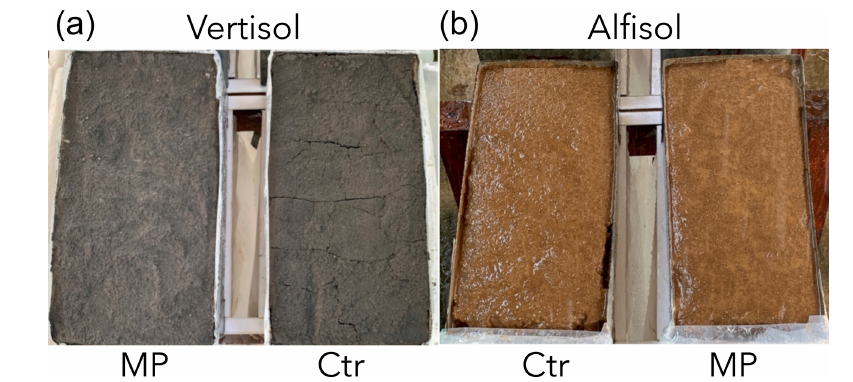
Figure 9. Experimental units of experiment II ( a Vertisol and b Alfisol) after the rainfall